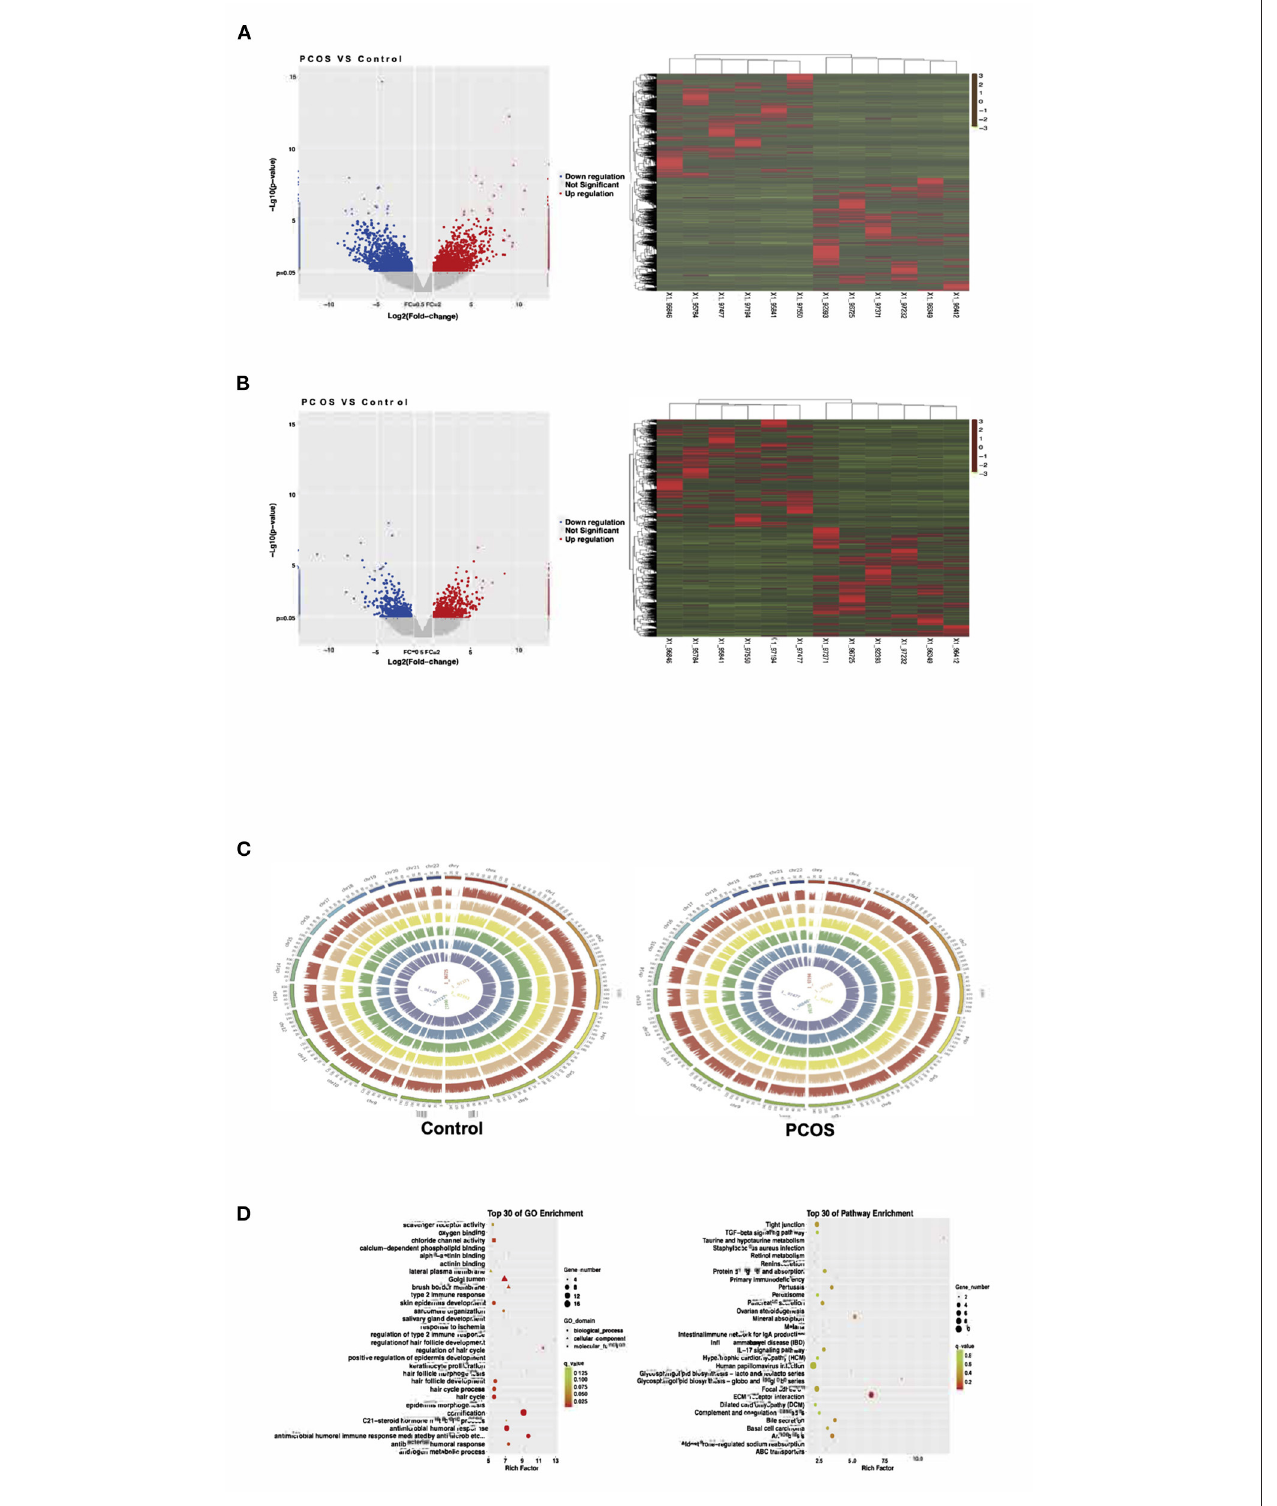
FIGURE 1 | The expression of ovarian granulosa cells mRNAs and lncRNAs from polycystic ovary syndrome (PCOS) patients and controls. (A) Volcano map and Heat map of differentially expressed mRNAs ( p < 0.05). (B) Volcano map and Heat map of differentially expressed lncRNAs ( p < 0.05). (C) The distribution of differentially expressed lncRNAs in human chromosomes. (D) Gene Ontology (GO) and Kyoto Encyclopedia of Genes and Genomes (KEGG) pathway analysis for all target genes.